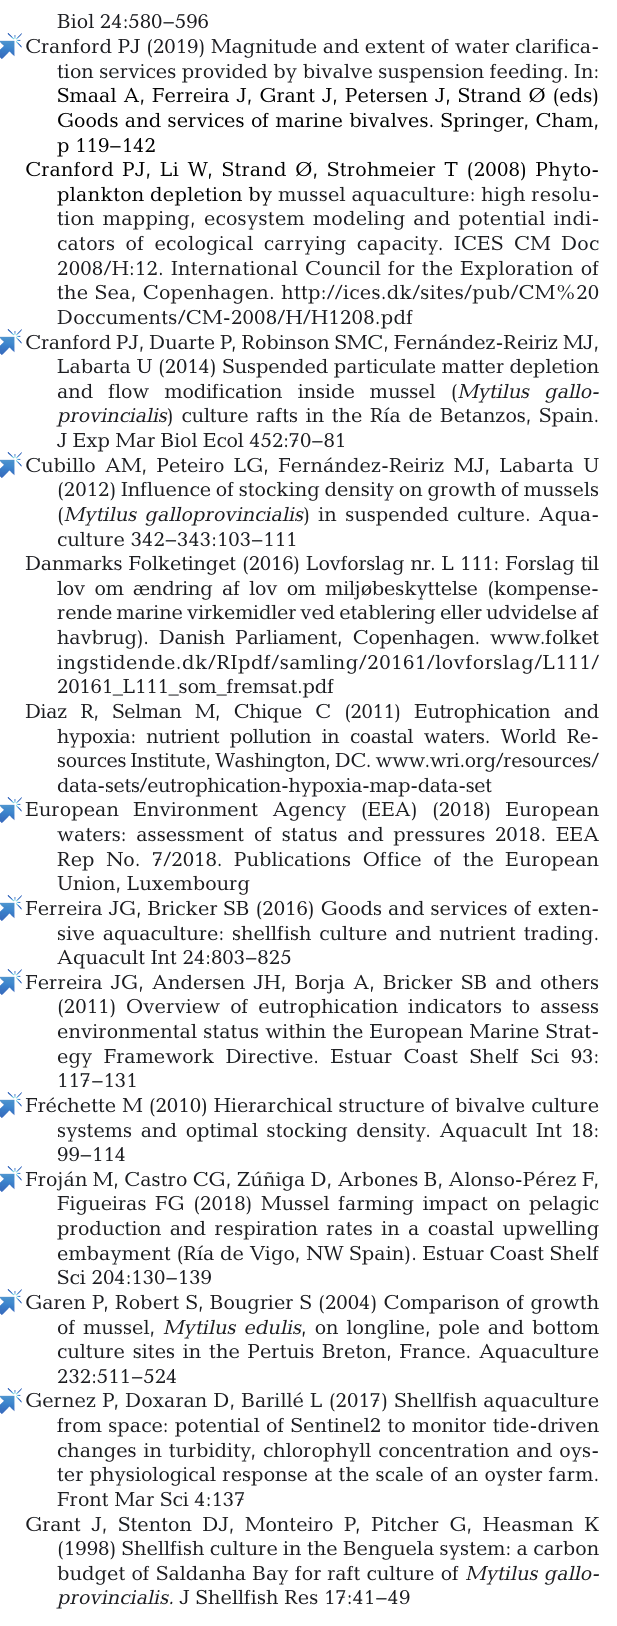
Figueiras FG (2018) Mussel farming impact on pelagic production and respiration rates in a coastal